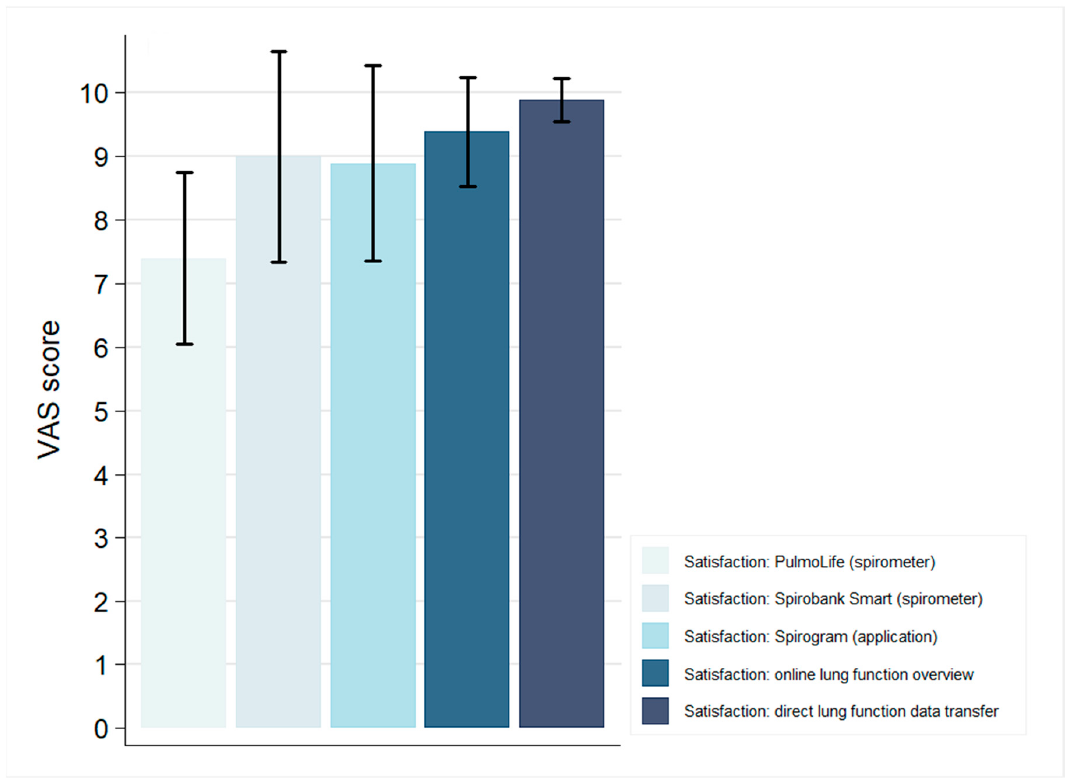
Figure 2. Mean patient satisfaction and experiences, scored on visual analogue scales from 0 to 10. Standard deviation (SD) is represented by the error bars. VAS: visual analogue scale.